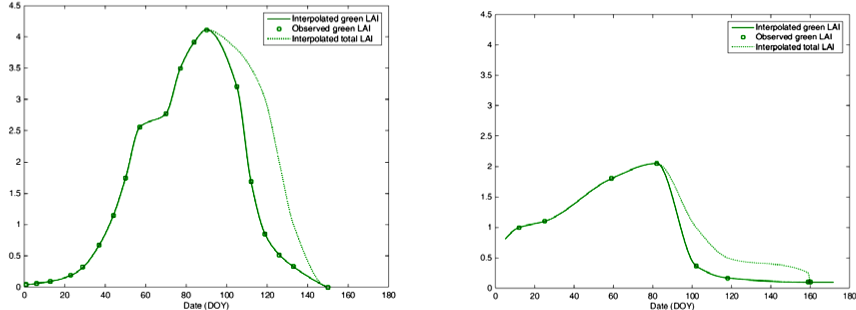
Figure 5. Evolution of green and total leaf area index in the irrigated wheat (left) and rainfed wheat (right)